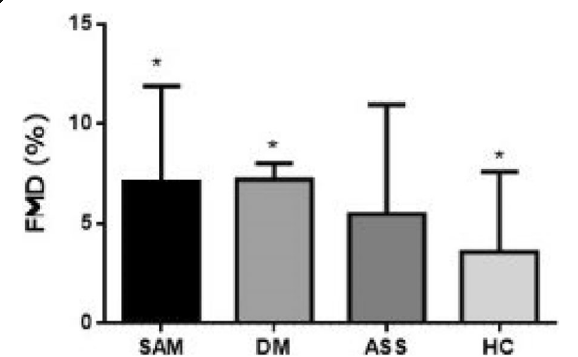
Fig. 1 (abstract O29). Flow mediated dilatation in systemic autoimmune diseases (SAM): dermatomyositis (DM), antisynthetase syndrome (ASS), compared to health control (HC).